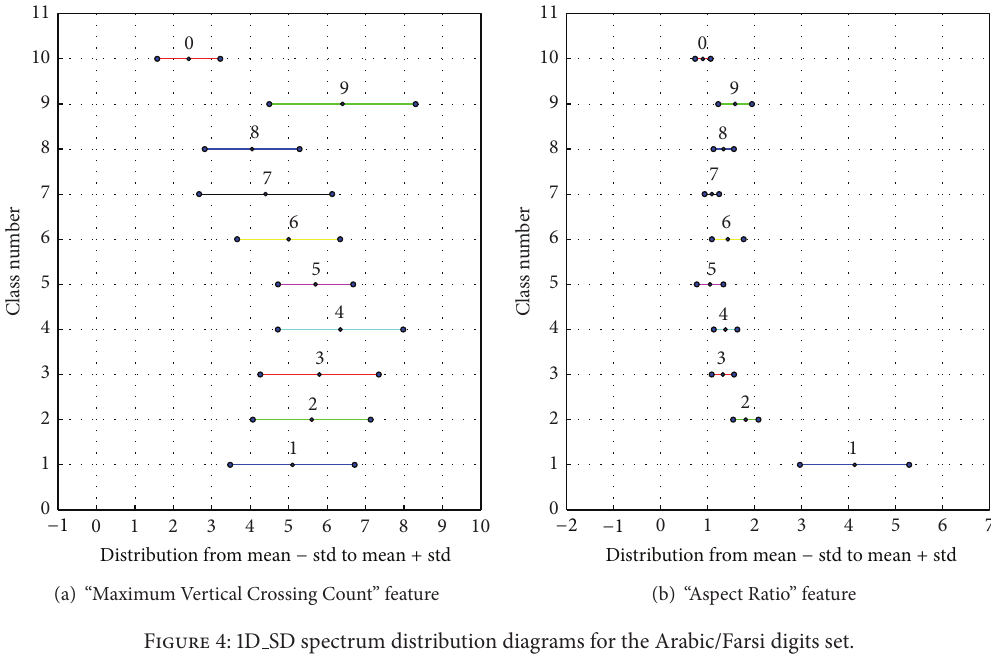
Figure 4: 1D SD spectrum distribution diagrams for the Arabic/Farsi digits set.